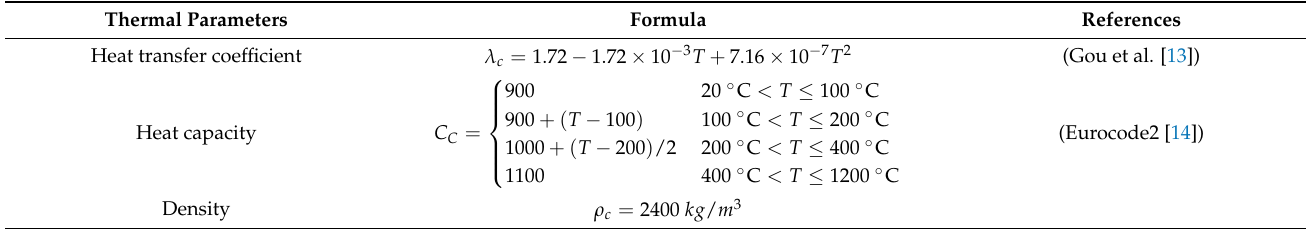
Table 1. Thermal parameters of concrete at elevated temperature.